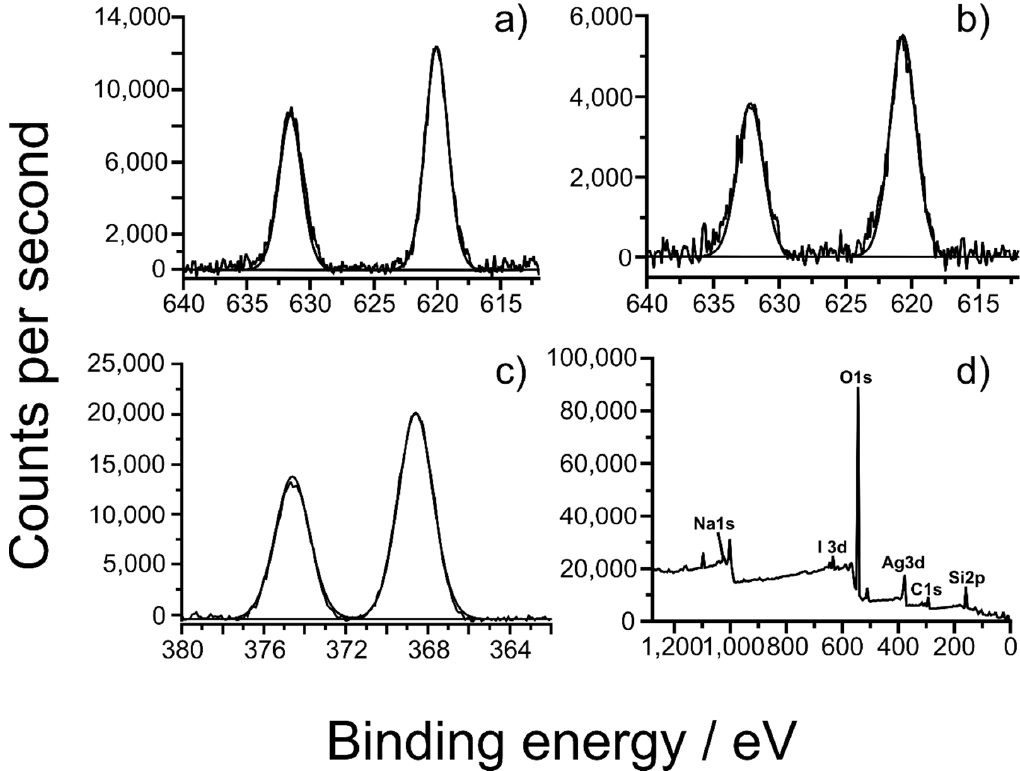
Figure 11. XPS results after interaction with iodide. Figures show: high resolution scans of ( a ) I3d of Ag 0 @NZU at 200 ppm I ‐ , ( b ) I3d of Ag 2 O@NZU at 800 ppm I − , ( c ) Ag3d of Ag 0 @NZU at 800 ppm I −